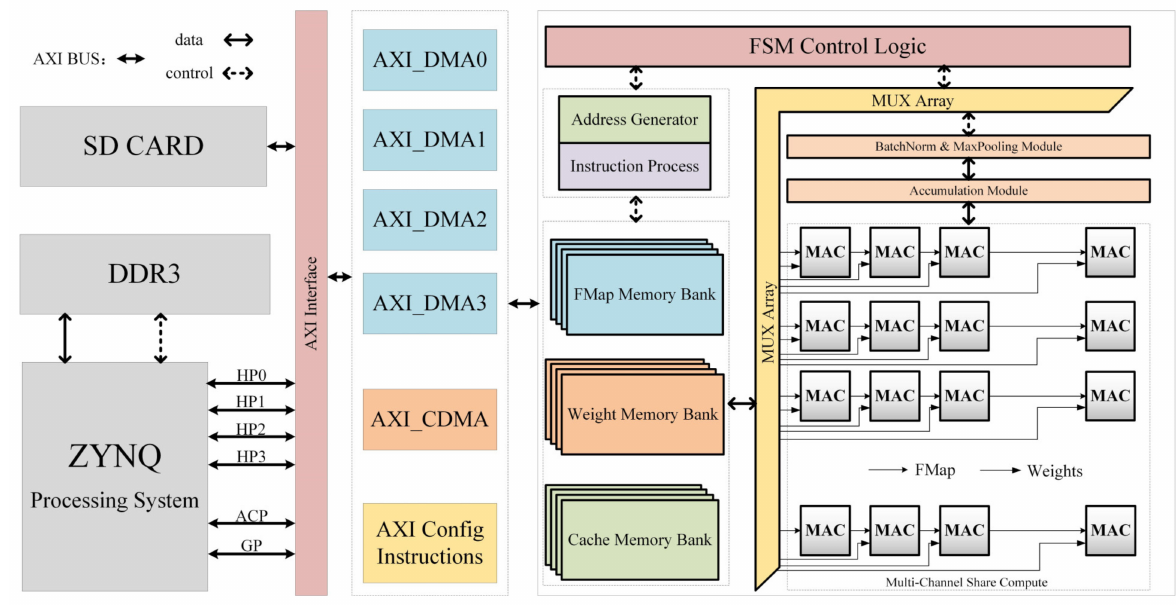
Figure 2. The overall architecture of SoC.